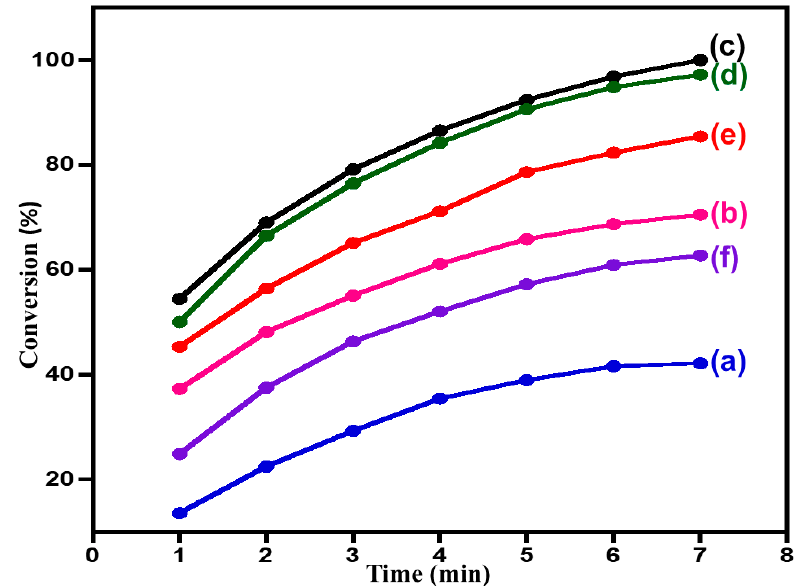
Figure 6. Graphical illustration of benzyl alcohol oxidation using the catalysts ( a ) MnCO 3 ; ( b ) ZnO x (1%)–MnCO 3 ; ( c ) ZnO x (1%)–MnCO 3 /(1%)HRG; ( d ) ZnO x (1%)–MnCO 3 /(3%)HRG; ( e ) ZnO x (1%)– MnCO 3 /(5%)HRG; and ( f ) ZnO x (1%)–MnCO 3